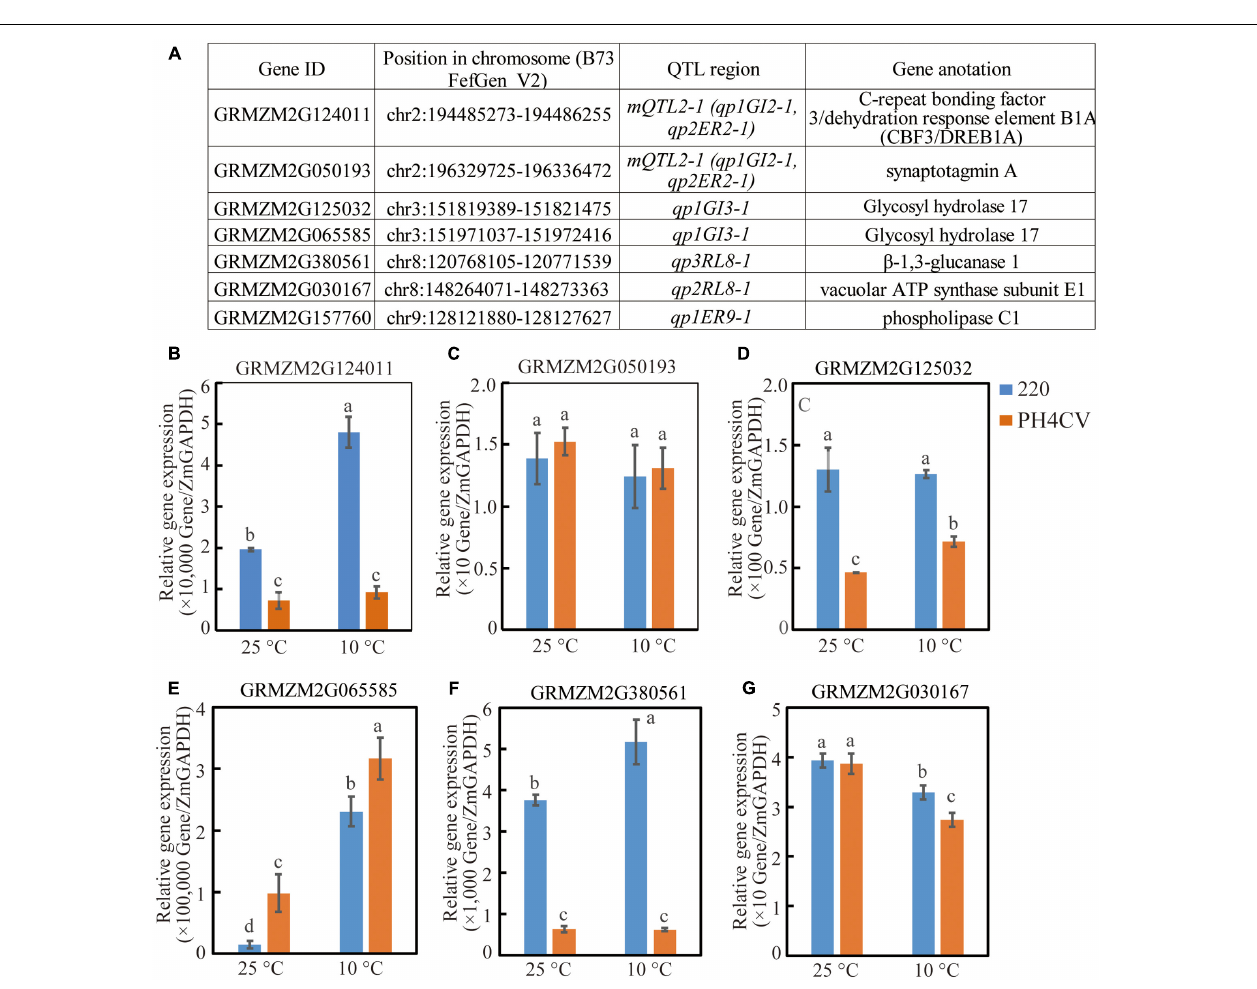
FIGURE 4 | Expressions of six candidate genes in parent lines 220 and PH4CV. Expression were conducted on shoots that were collected at 15 days after sowing (DAS) and 3 DAS under low (10 ◦ C) and normal (25 ◦ C) temperature, respectively. (A) Candidate genes and their chromosome locations. (B–G) Expression for different